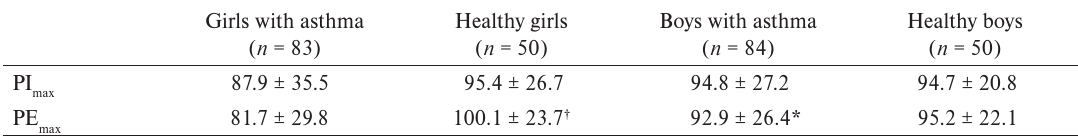
Table 2 PI and PE values in percentage of predicted in children with asthma and healthy children (mean ± SD) max max Girls with